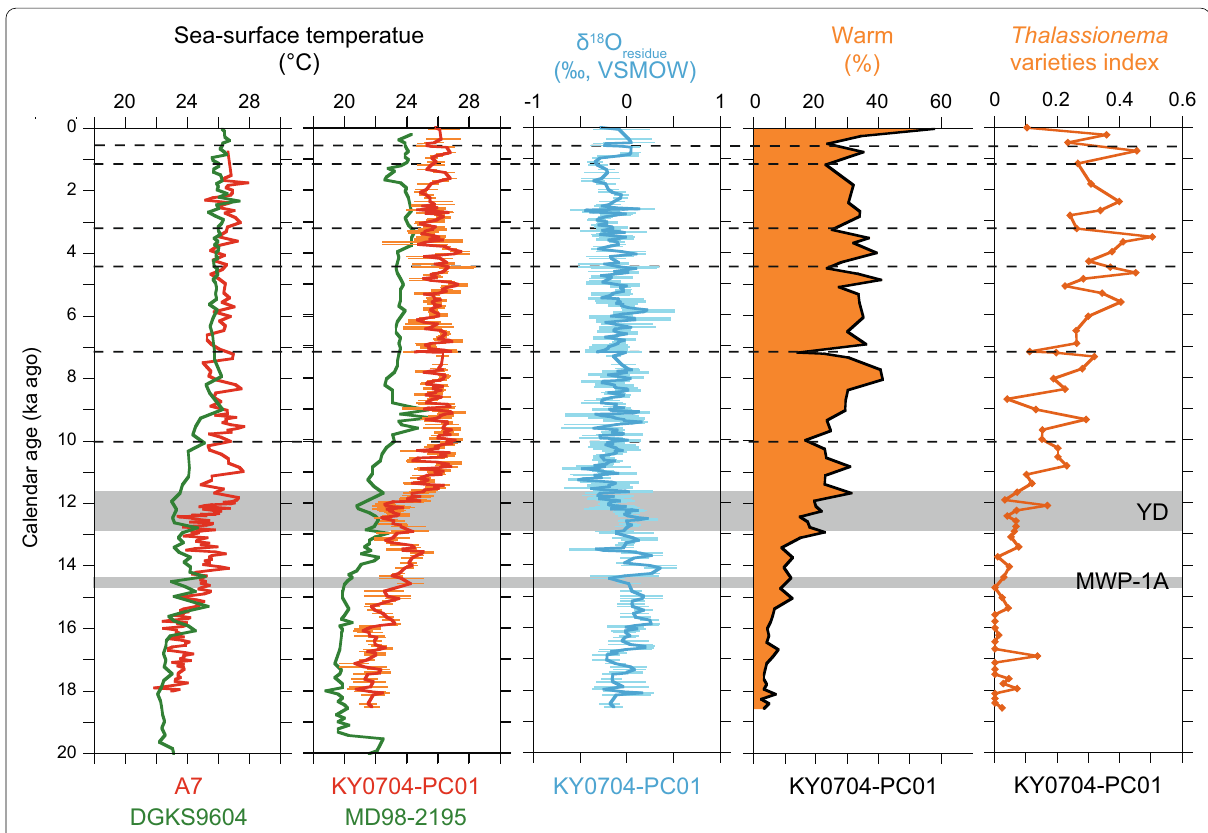
Fig. 5 Sea-surface temperature records based on planktic foraminiferal Mg/Ca (red) and alkenones in the central Okinawa Trough: Core A7 (Sun et al. 2005) and Core DGKS9604 (Yu et al. 2009); and the northern Okinawa Trough: Core KY07-04 PC01 (Kubota et al. 2010, 2015b) and Core MD98-2195 (Ijiri et al. 2005) as well as residual δ 18 O as a salinity proxy in Core KY07-04 PC01(Kubota et al. 2010, 2015a, b). SST and residual δ 18 O at Core KY07-04 PC01 and the errors ( 1 σ ) were derived by Paleo-Seawater Uncertainty Solver (PSU Solver) (Thirumalai et al. 2016) with the ± methodology of Kubota et al. (2019). Downcore profiles of relative abundances (%) of warm diatom indicators and Thalassionema variety index in Core KY07-04 PC01 were also shown. Gray hatches indicate MWP-A and YD periods. Horizontal broken lines denote pronounced decreases in warm diatom indicators during